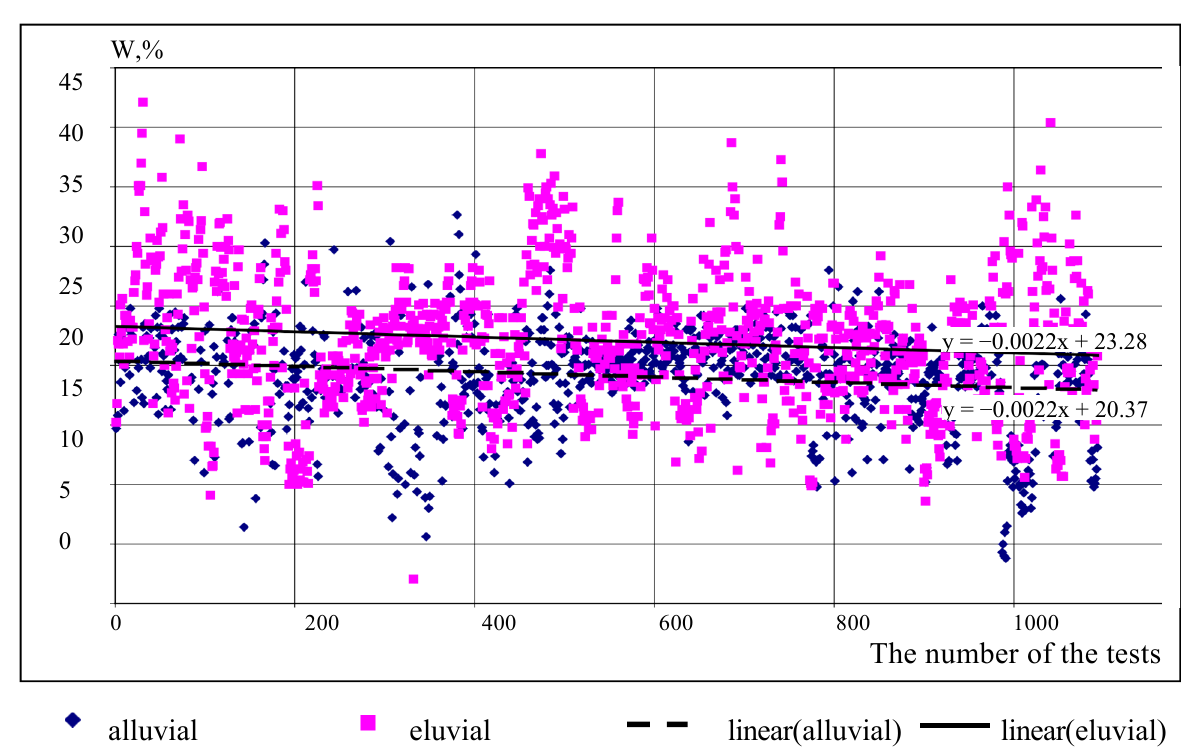
Figure 4. Scatter plot of the natural moisture content for alluvial and eluvial clay soils.